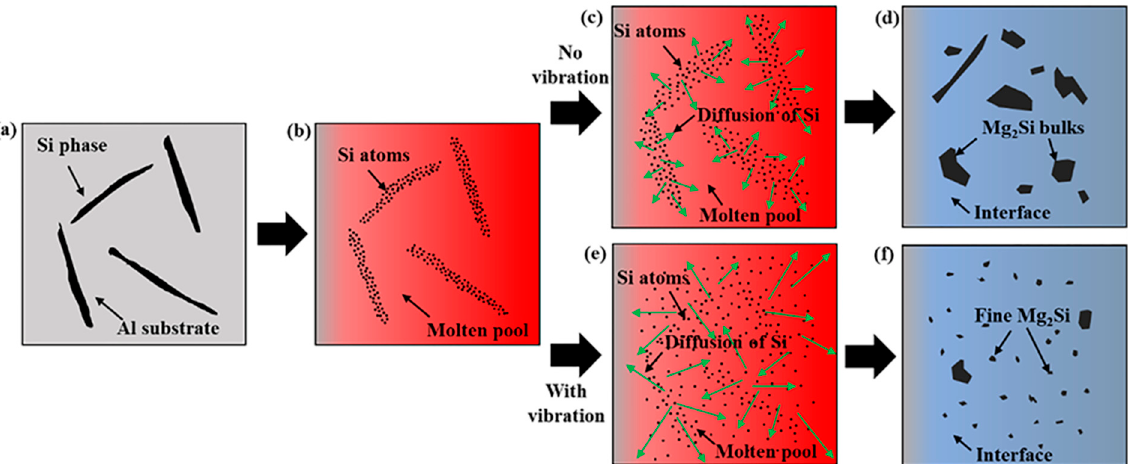
Figure 13. The influence mechanism of the vibration on the size and distribution of the Mg 2 Si phase: ( a ) The initial state of the Si element; ( b ) The insert melted to form a molten pool on the surface of the solid insert; ( c ) The diffusion of the Si in the molten pool under the condition of no vibration; ( d ) The interface formed under the condition of no vibration; ( e ) The diffusion of the Si in the molten pool after applying the vibration; ( f ) The interface formed after applying the vibration.